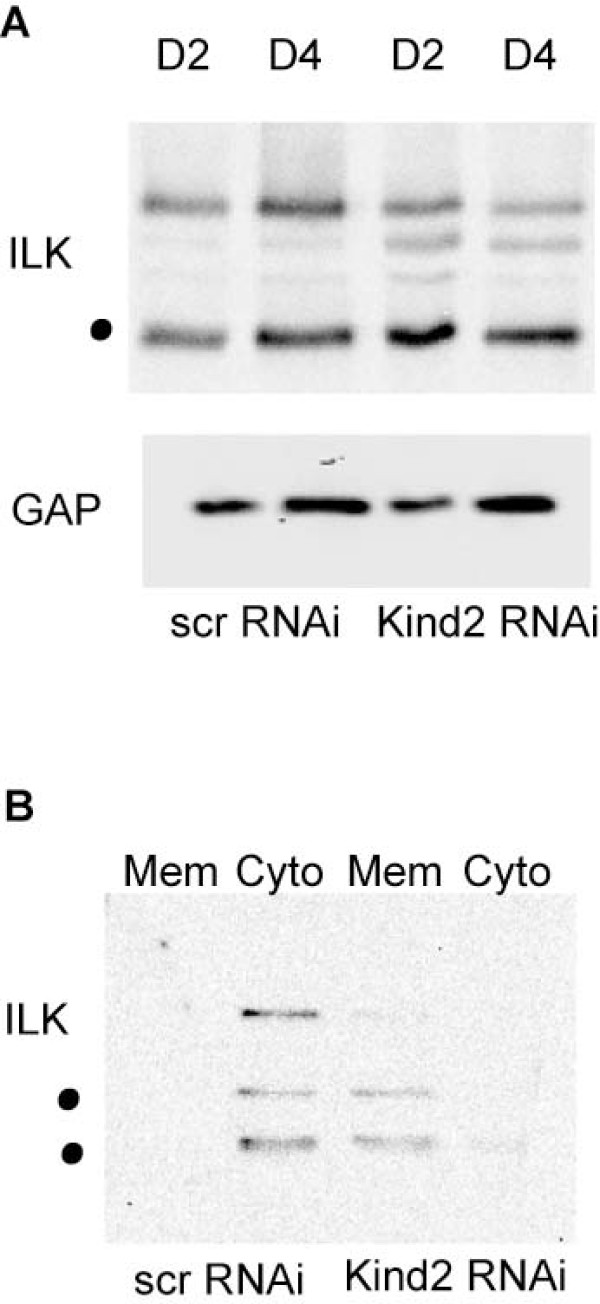
ILK localization is altered with kindlin-2 knockdown. A. Immunoblot on protein from C2C12 cells at differentiation day 2 (D2) and day 4 (D4) transfected with scrambled (scr) or kindlin-2 (kind2) RNAi. Blots were probed with anti-ILK and anti-GAPDH. No difference by densitometry was detected between scrambled and kindlin-2 RNAi cells. Dot indicates ILK band. B. Immunoblot on subcellular fractions from day 2 differentiated C2C12 cells probed with anti-ILK. ILK localizes to the cytosolic (cyto) fraction in scrambled RNAi cells and to the membrane/insoluble (mem) fraction in kindlin-2 RNAi cells. No expression was seen with either condition in the cytoskeletal or nuclear fractions (data not shown).